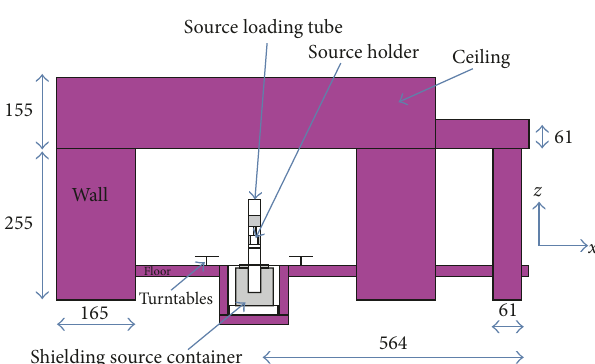
Figure 2: MCNPX model 𝑋𝑍 view of the Gamma Irradiation Laboratory.